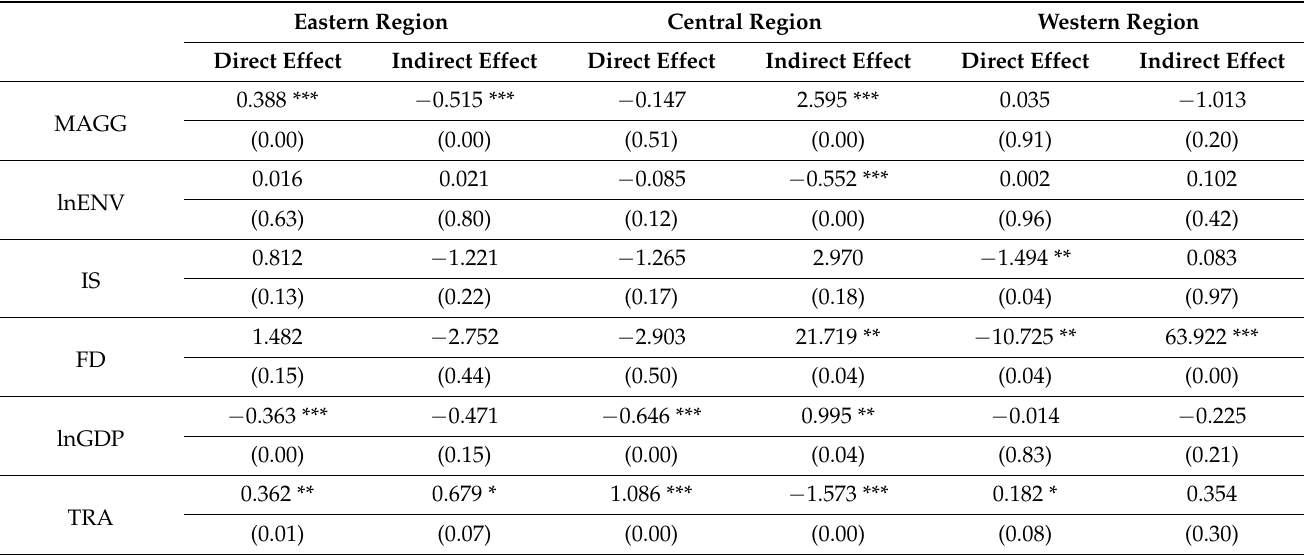
Table 10. Decomposition results of spatial effects in eastern, central, and western regions. Eastern Region Central Region Western